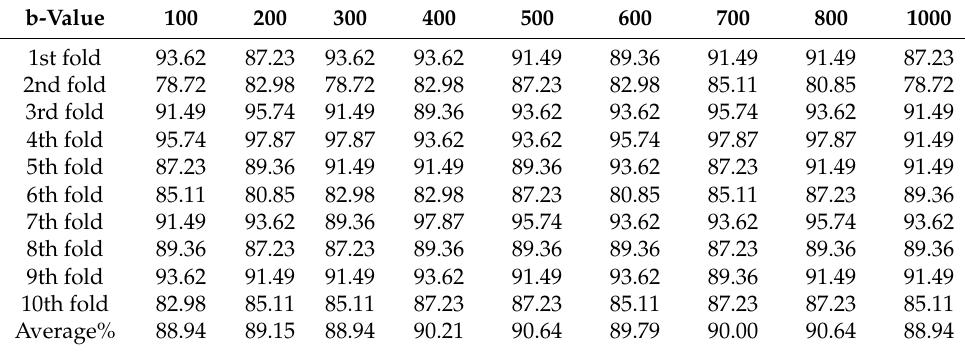
Table 5. 10-fold cross validation of AlexNet at 9